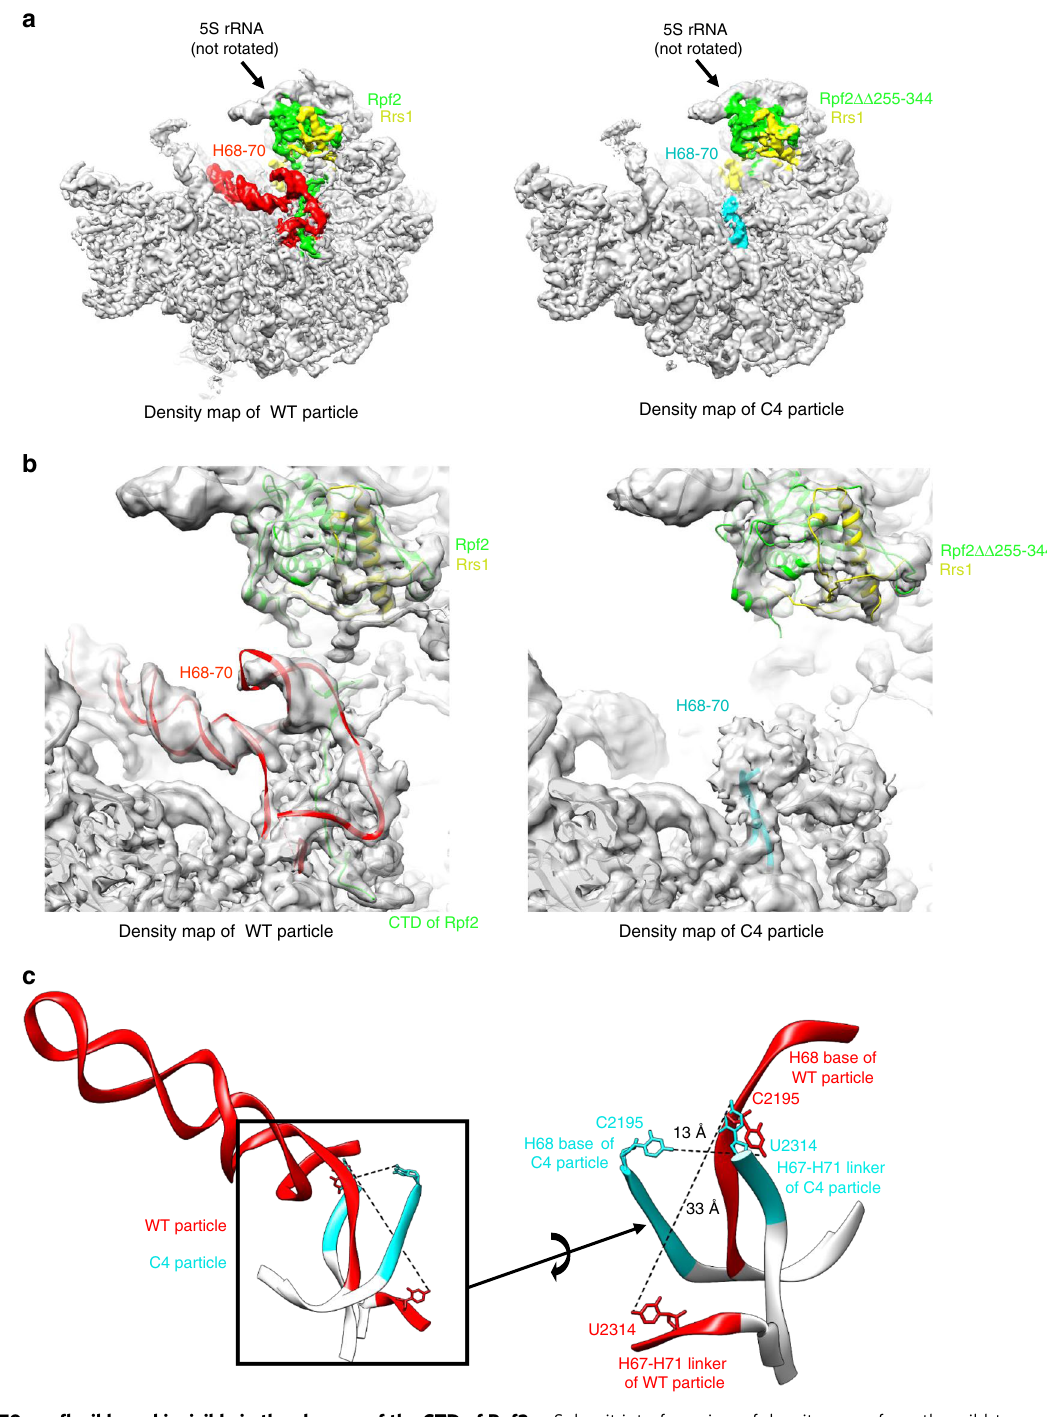
Fig. 3 H68-70 are fl exible and invisible in the absence of the CTD of Rpf2. a Subunit interface view of density maps from the wild-type particles and the C4 class of rpf2 Δ 255-344 mutant particles. Densities for Rpf2, Rrs1, and H68-70 were colored using Color Zone in Chimera. b Atomic models for wild-type and C4 particles were fi tted into density maps of wild-type and C4 particles, respectively. The C4 class of the rpf2 Δ 255-344 particles is missing densities for the CTD of Rpf2 and for H68-H71, except for the base of H68 and the H67-H71 linker. c Structural comparison of atomic models of the wild-type particle and mutant C4 particle in the stem base region of H68. One strand of the base of H68 in the C4 mutant is de fl ected up to 13 Å, as indicated by the displacement of C2195, and the H67-H71 linker is de fl ected up to 33 (Fig. 3). Importantly, in contrast to the wild-type Nog2 sample, in classes of mutant particles (Fig. 3a and Supplementary Fig. 6b). Therefore, deletion of the CTD of Rpf2 blocks 5S RNP rotation. which a small population of particles contains Sda1 (State 2) 27 , no Sda1-containing particles were observed in structural classi fi ca- tion of the rpf2 Δ 255-344 mutant pre-ribosomes. Consistent with the absence of Sda1, the 5S RNP was in its pre-rotated state in all